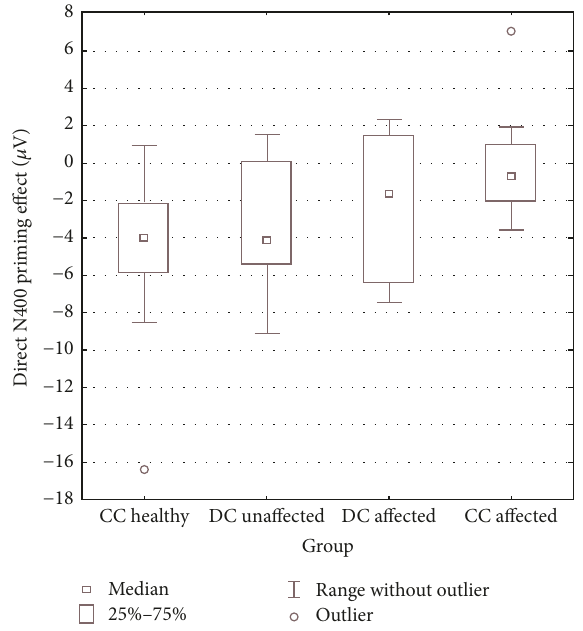
Figure4:BoxplotdepictingthedistributionofdirectN400priming effect (in microvolts) across the monozygotic twins: concordant healthy (CC healthy, 𝑁 = 38 ), discordant unaffected (DC unaf- fected, 𝑁 = 11 ), discordant affected (DC affected, 𝑁 = 11 ), and concordant for schizophrenia/schizoaffective disorder (CC affected, 𝑁 = 12 ).